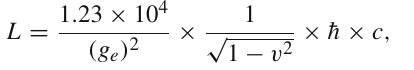
Fig. 2 Left: the differential cross-sections with respect to cos θ . Right: the cross-section as a function of the CMS energy refers to the complete “vector minus axial-vector” contributions, while “V only” stands for the vector case